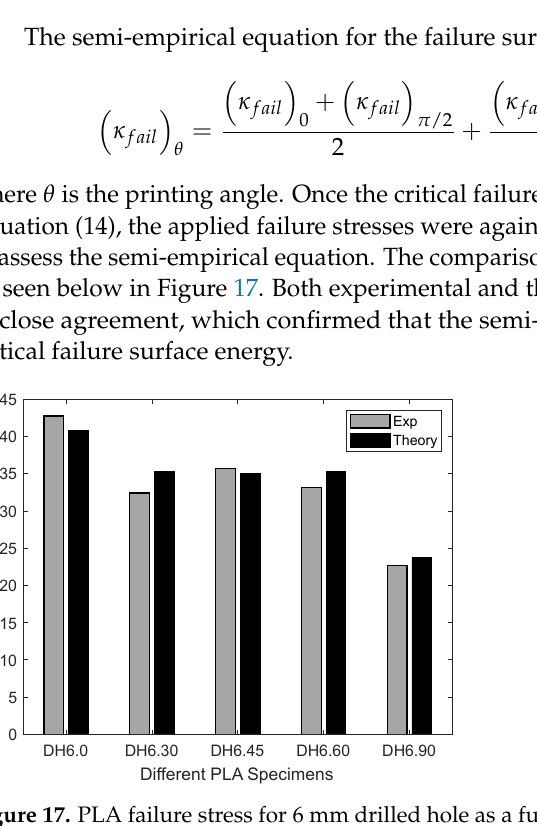
Figure 16. Experimental and theoretical failure stress for drilled PLA specimens.